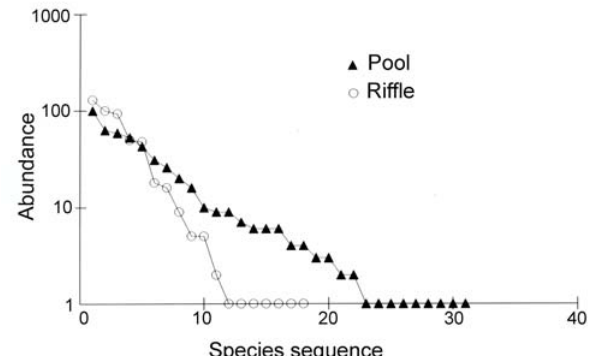
Fig. 1. Model of species abundance for each mesohabitat studied in the ribeirão Santa Bárbara, southeastern Brazil.